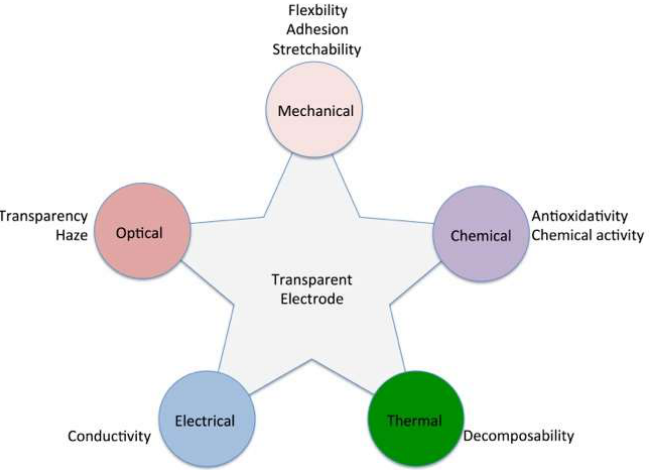
Figure 10. Schematic drawing of the basic factors for evaluating transparent electrodes.